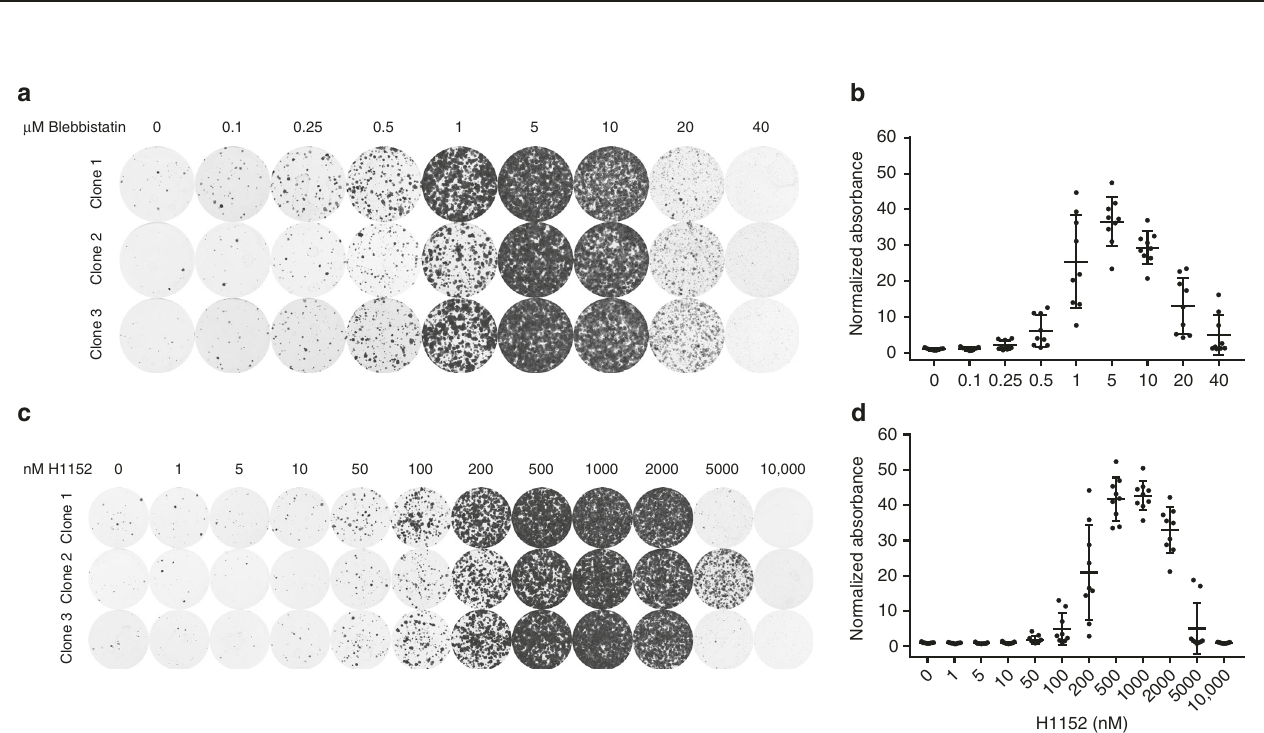
Fig. 3 Actomyosin relaxation enables survival upon E-cadherin loss. a Merged bright fi eld and GFP images of MMECs isolated from Wcre;mTmG and Wcre; Cdh1 F/F ;mTmG female mice in the absence or presence of 10 µ M Y-27632. Asterisks indicate areas of zoom, red dotted lines display outgrowth of E- cadherin-de fi cient MMECs. Zooms display altered cell adhesion in the absence or presence of Y-27632 of GFP-positive E-cadherin-de fi cient cells derived from Wcre;Cdh1 F/F ;mTmG female mice. Scale bar, 50 µ m. b Western blot analysis of Wcre;mTmG and Wcre;Cdh1 F/F ;mTmG MMECs stained for E-cadherin and tubulin (loading control). c Western blot analysis of subclones derived from the Wcre;mTmG and Wcre;Cdh1 F/F ;mTmG MMECs stained for E-cadherin and tubulin (loading control). d Bright fi eld images of MMECs 3 h post seeding in the absence or presence of 10 µ M Y-27632 or 10 µ M blebbistatin. Scale bar, 20 µ m. e Western blot analysis of pSer 473 Akt, Akt, cleaved caspase-3, and actin (loading control) in Wcre;Cdh1 F/F ;mTmG subclones grown in the absence or presence of 10 µ M Y-27632. f , g Representative images ( f ) and quanti fi cation ( g ) of clonogenic assays with Wcre;mTmG (circles) and Wcre; Cdh1 F/F ; mTmG (squares) subclones grown in the presence or absence of 10 µ M Y-27632 or 10 µ M blebbistatin (7 days after seeding the cells). Data are of three independent experiments with three clones per experiment. h Western blot analysis of WT FVB and Cdh1 Δ / Δ MMECs stained for E-cadherin and actin (loading control). i , j Representative images ( i ) and quanti fi cation ( j ) of clonogenic assays with Cdh1 Δ / Δ and WT control MMEC lines with or without 10 µ M Y-27632. Data are of three independent experiments. k Representative images of immunoblots of active RhoA pull-down assays and ser 19 myosin light chain phosphorylation (pMLC) from Cdh1 Δ / Δ and WT control MMECs harvested 3 h post seeding. l Quanti fi cation of active RhoA pull-down assays by densitometry normalized to the actin loading control. Data are of three independent experiments. All data are depicted as mean ± standard deviation. All p